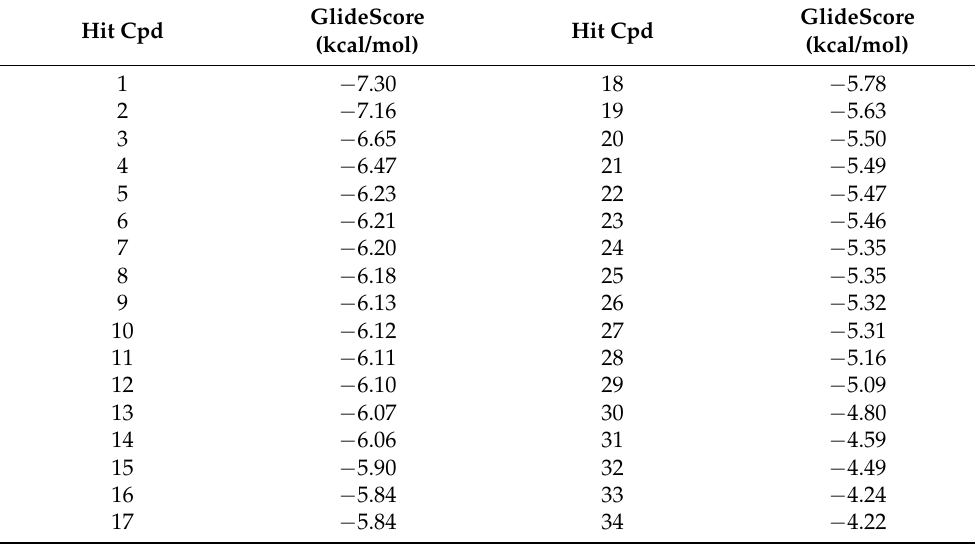
Table 1. The hits generated from the virtual combinatorial library and their respective